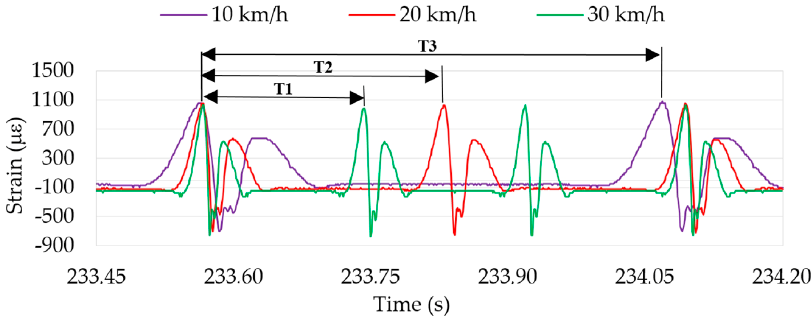
Figure 7. Speed influence in the period.